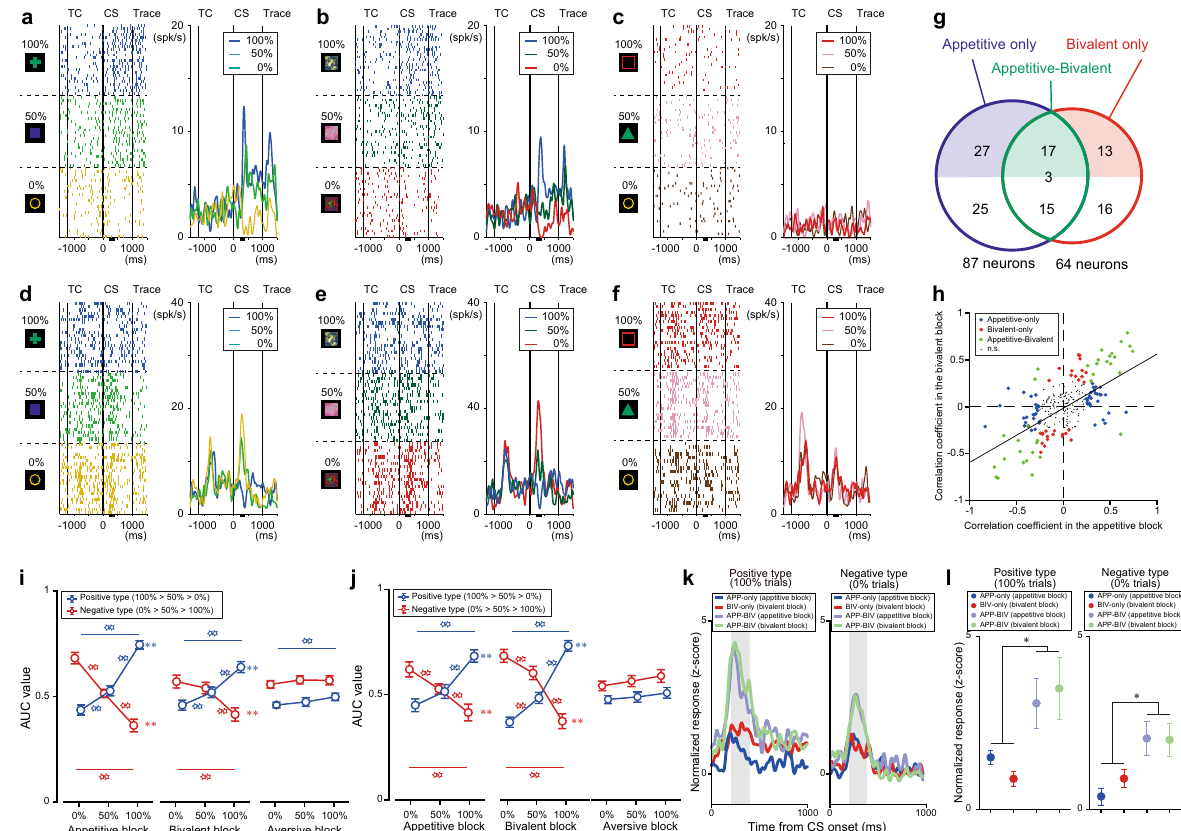
Figure 2. Conditioned stimulus (CS) value-coding neurons in the lateral hypothalamus. ( a–f ) Representative responses of a positive CS value-coding neuron in the appetitive ( a ), bivalent ( b ), and aversive ( c ) blocks and a negative type in the appetitive ( d ), bivalent ( e ), and aversive ( f ) blocks in the rasters ( left ) and histograms ( right ). TC, timing cue. Horizontal black bars indicate the analysis time window. ( g ) Number of CS value- coding neurons in the appetitive and bivalent blocks. The labels indicate the CS value-coding neurons with significantly correlated activity according to reward probability only in the appetitive blocks (blue), only in the bivalent blocks (red), and in both blocks (green), respectively. Colored and white areas depict positive and negative types, respectively. Digit on the border between the colored and white areas is the number of neurons with different correlation signs between the blocks. ( h ) Consistent sensitivity of CS values between the appetitive and bivalent blocks ( p = 1.86 –20 , ρ = 0.55, Spearman’s correlation test). Each dot represents a single lateral hypothalamus neuron. Dot colors depict neuron types in g. ( i,j ) Preferred responses of CS value-coding neurons with significant CS value-dependent activity in the appetitive ( i ) or bivalent ( j ) blocks. The responses were indexed by the area under the curve (AUC) value during the test window (201–400 ms after CS onset) relative to the responses for the last 500 ms before timing cue (TC) onset (** p < 0.01/3, Wilcoxon signed-rank test with Bonferroni’s correction; ** p < 0.01, Spearman’s correlation test). ( k–l ) Larger response modulation of the appetitive-bivalent (APP-BIV) neurons than that of the appetitive-only (APP-only) and bivalent-only (BIV- only) neurons ( k ) and mean values during 201–400 ms after CS onset (gray areas in k) for the positive ( left ) and negative ( right ) types ( l ). Normalized activity ( z -score) was computed by using the activity during the last 500 ms before TC onset. The activity in the 100% trials was compared between the blocks for the positive types ( left ), while that in the 0% trials was compared for the negative types ( right ). * p < 0.05, one-way ANOVA and post-hoc Fisher’s least significant difference Graded responses to CS values with bidirectional responses. To capture the graded responses to CS values associated with reward probability in parallel with the graded approaching behaviors, we applied correlation testing between CS values and the mean CS activity (201–400 ms after CS onset). In the appetitive blocks, 36% (87/244) of neurons exhibited responses that were correlated with the CS values (“CS value-coding” neurons). Among them, 48% (42/87) had a positive correlation (“positive type;” representative example, Fig. 2a; population, Fig. S1a,b), while the remaining 52% (45/87) had a negative correlation (“negative type;” representa- tive example, Fig. 2d; population, Fig. S1d,e). The activity of these neurons did not clearly differentiate the CS values predictive for airpuffs (punishment CS values) (representative examples, Fig. 2c,f; population, Fig. S1c,f). In the bivalent blocks, 26% (64/244) of the same population were classified as CS value-coding neurons. The proportion of positive and negative types was similar to that in the appetitive blocks (positive type: 32/64; nega- tive type, 32/64). A subset of the tested neurons exhibited graded activity consistently between the bivalent and